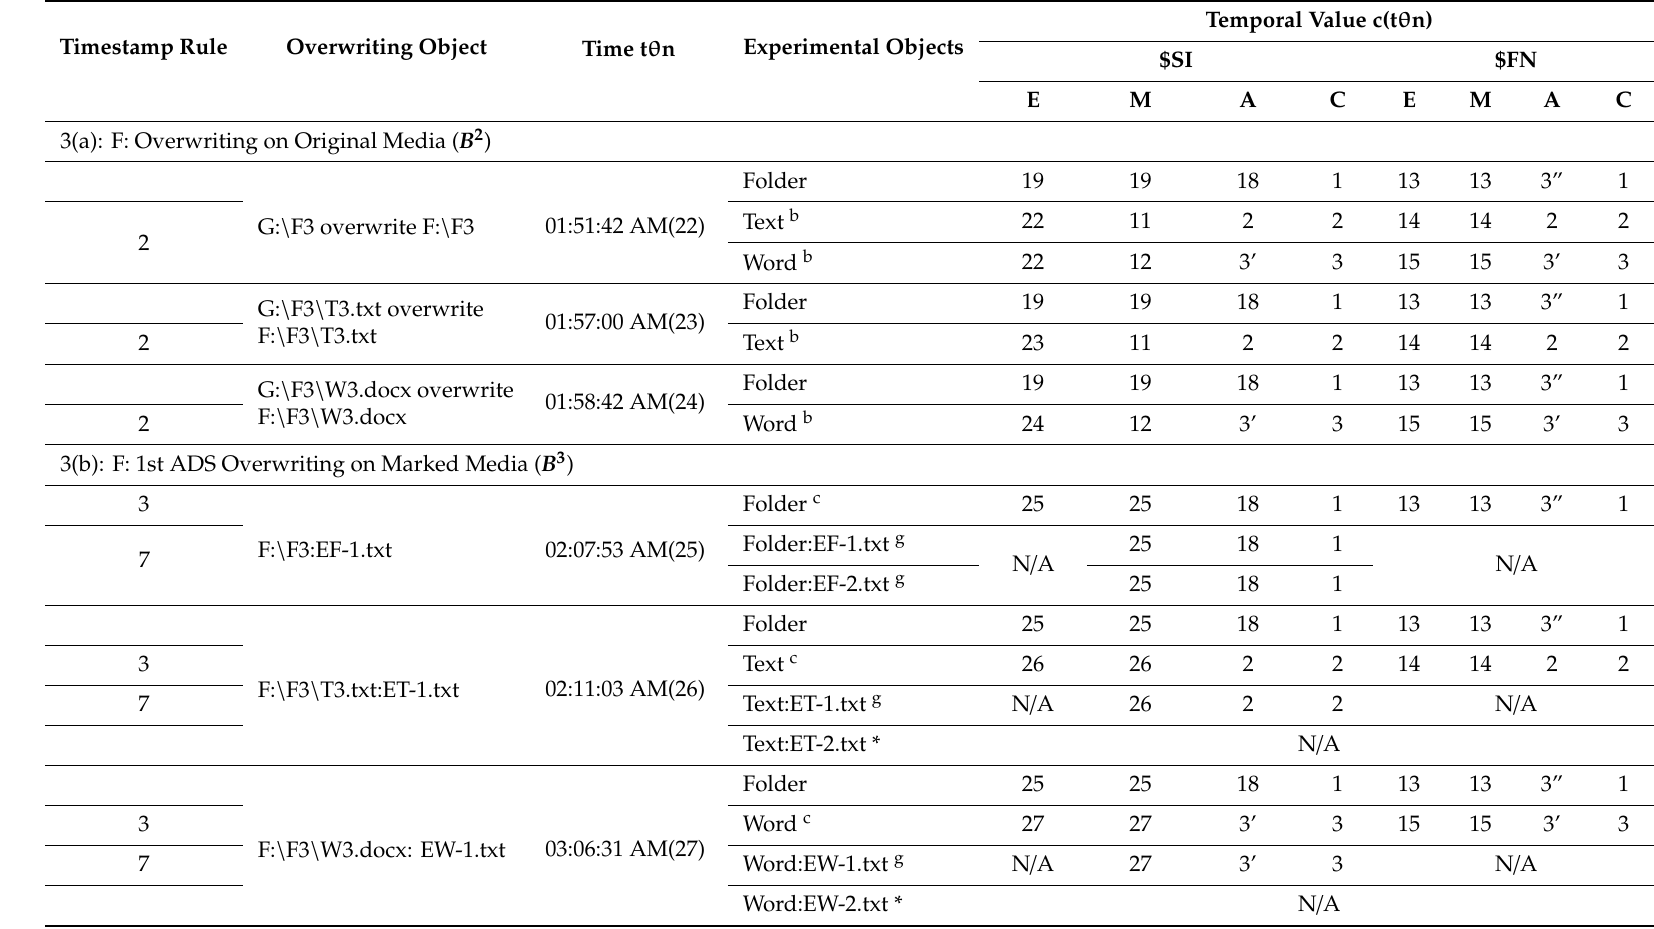
Table 8. Functional reconstruction on cover media overwriting (Stage